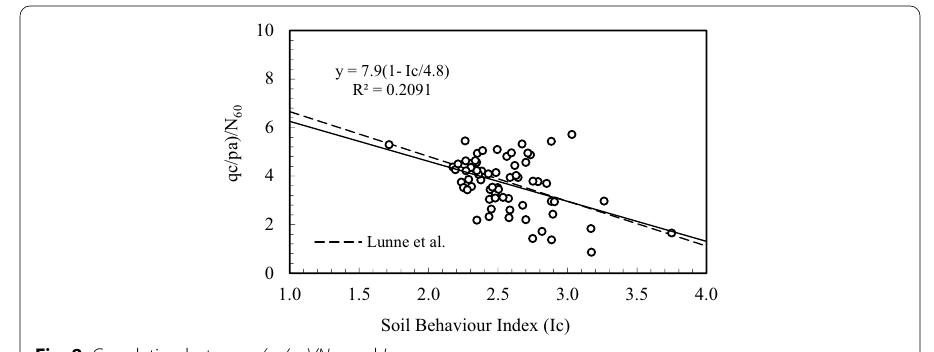
Fig. 8 Correlation between (q c /p a )/N 60 and